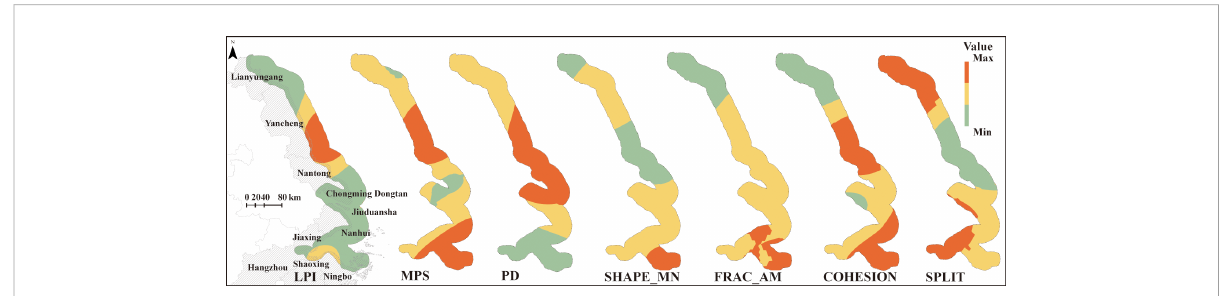
FIGURE 6 Distribution of landscape pattern indexes of tidal fl ats in 2020 (LPI, largest patch index; PD, patch density; MPS, mean patch area distribution; SHAPE_MN, mean shape index; FRAC_AM, area-weighted mean patch fractal dimension; COHESION, patch cohesion index; SPLIT, splitting